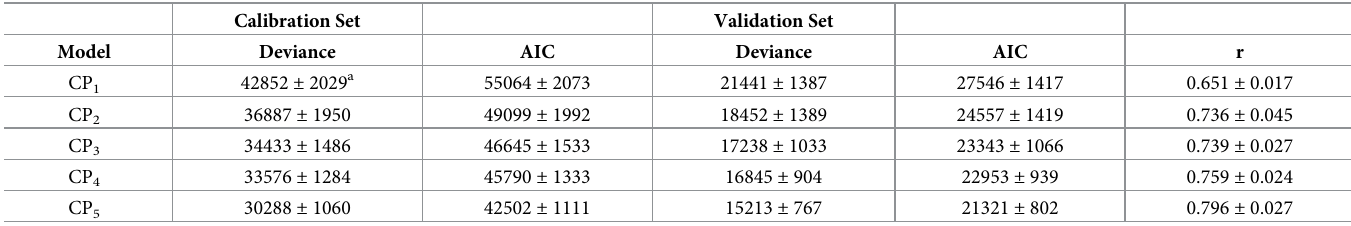
Table 5. Deviance, AIC and r for each model based on the simulation data.